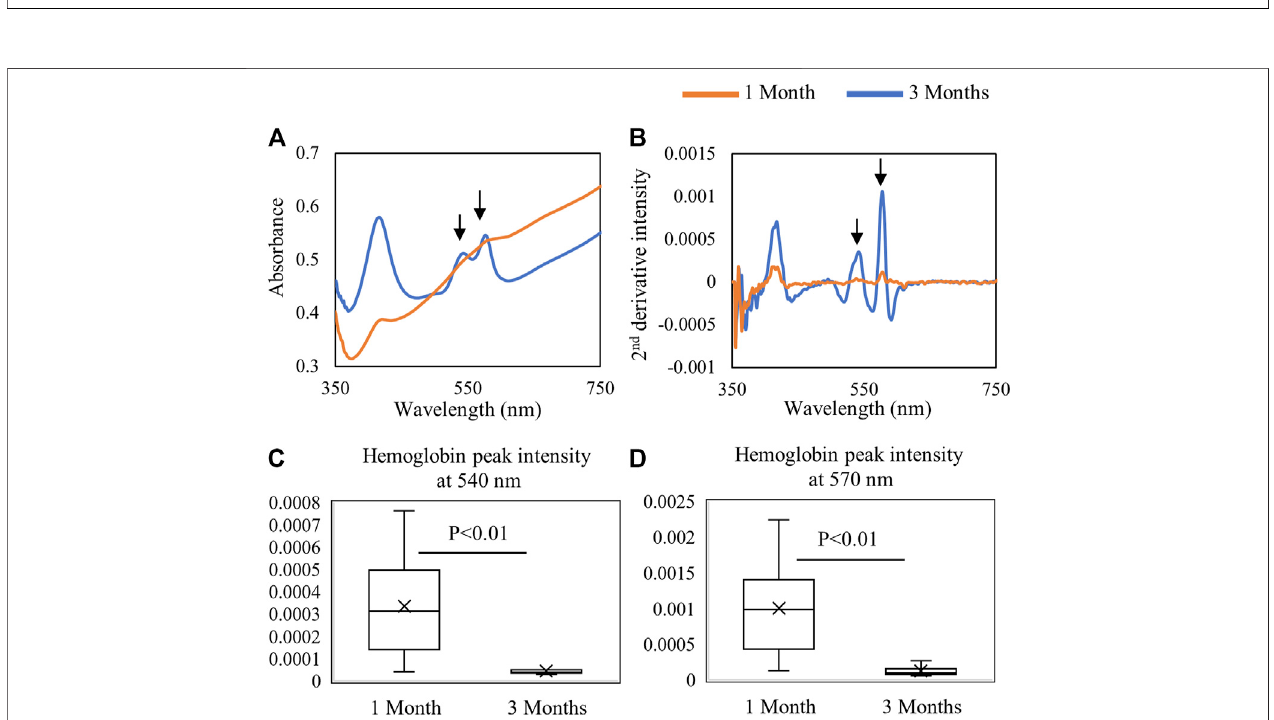
FIGURE6| Average (A) rawand (B) second-derivativeinvertedVis-NIRspectrafrom1-month( n =9)and3-month( n =6)defects insitu .Thevisiblespectraclearly depict the differences in hemoglobin absorbance (540 and 570 nm) between 1-month and 3-month repair. Quanti fi ed second-derivative peak intensities of hemoglobin peaks at (C) 540 nm and (D) 570 nm showing greater hemoglobin detection in the 1-month tissue (Student ’ s t -test).